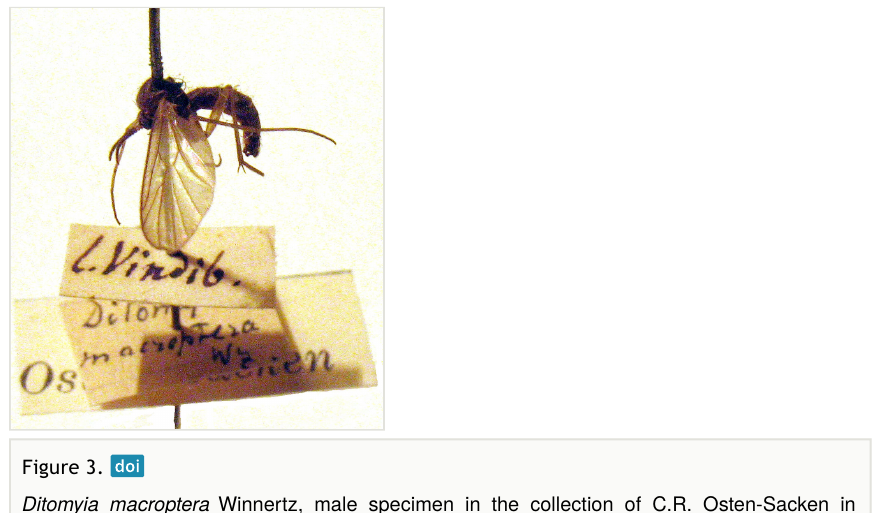
Ditomyia macroptera Winnertz, male specimen in the collection of C.R. Osten-Sacken